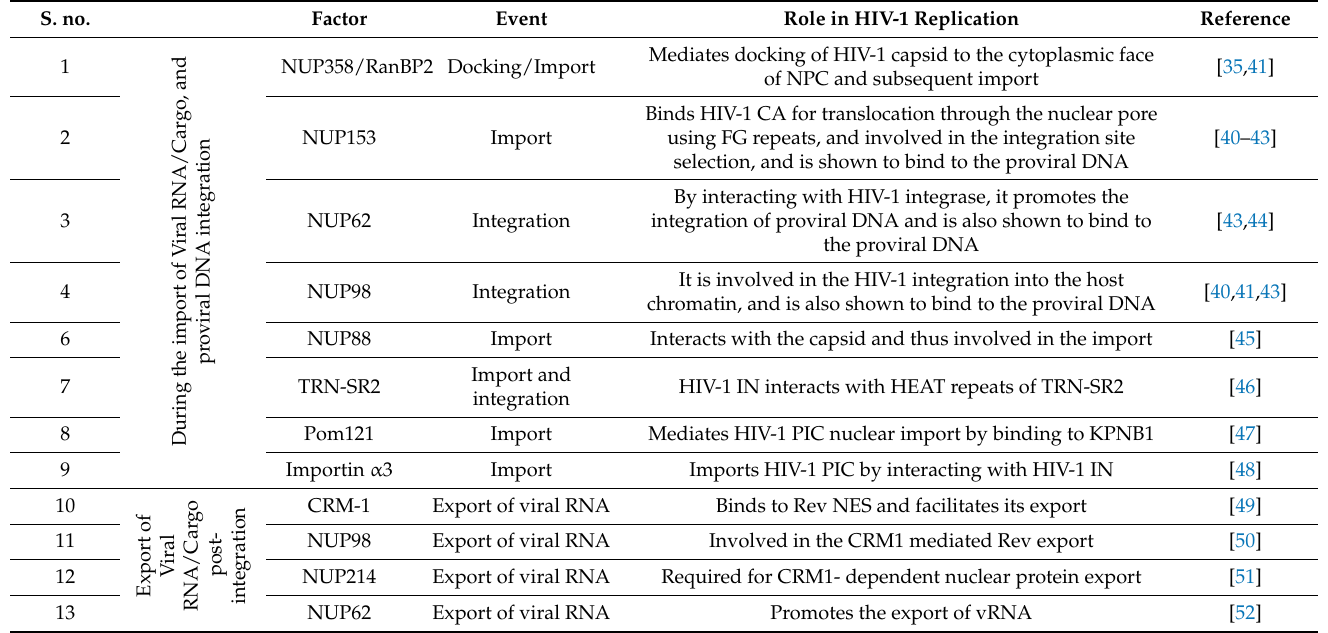
Table 1. List of nucleoporins and nuclear pore complex (NPC) associated proteins that participate in nucleocytoplasmic trafficking of HIV-1